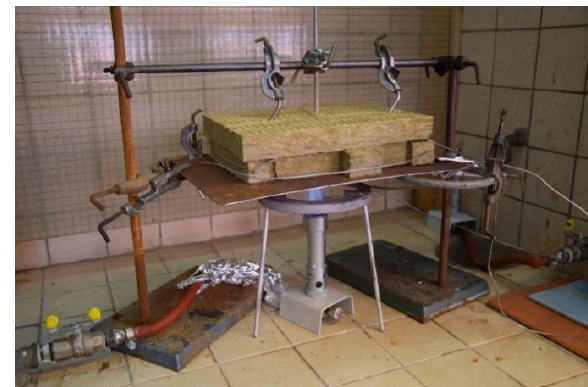
Figure 4. Experiment setup.